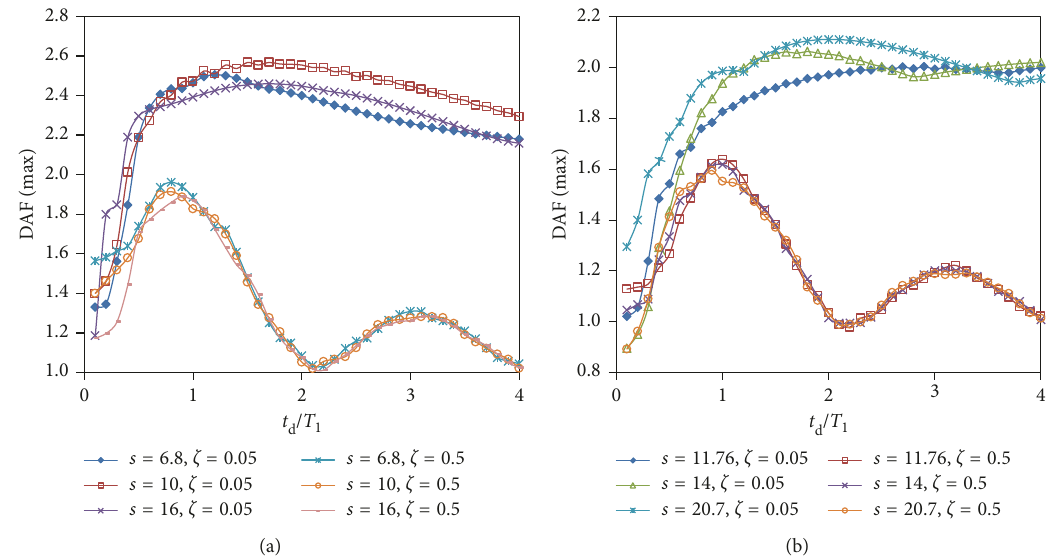
Figure 8: Maximum DAF of shear forces of bridge columns with different slenderness ratios under impact load with triangle shape and growth time. (a) F-F. (b)